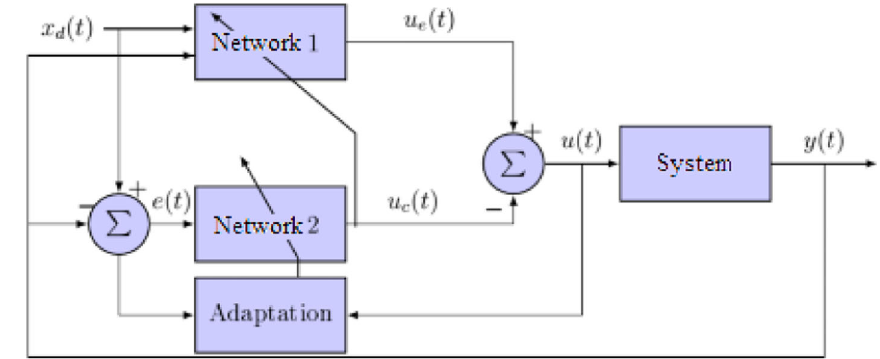
Fig. 13 Sliding-neural network modelling